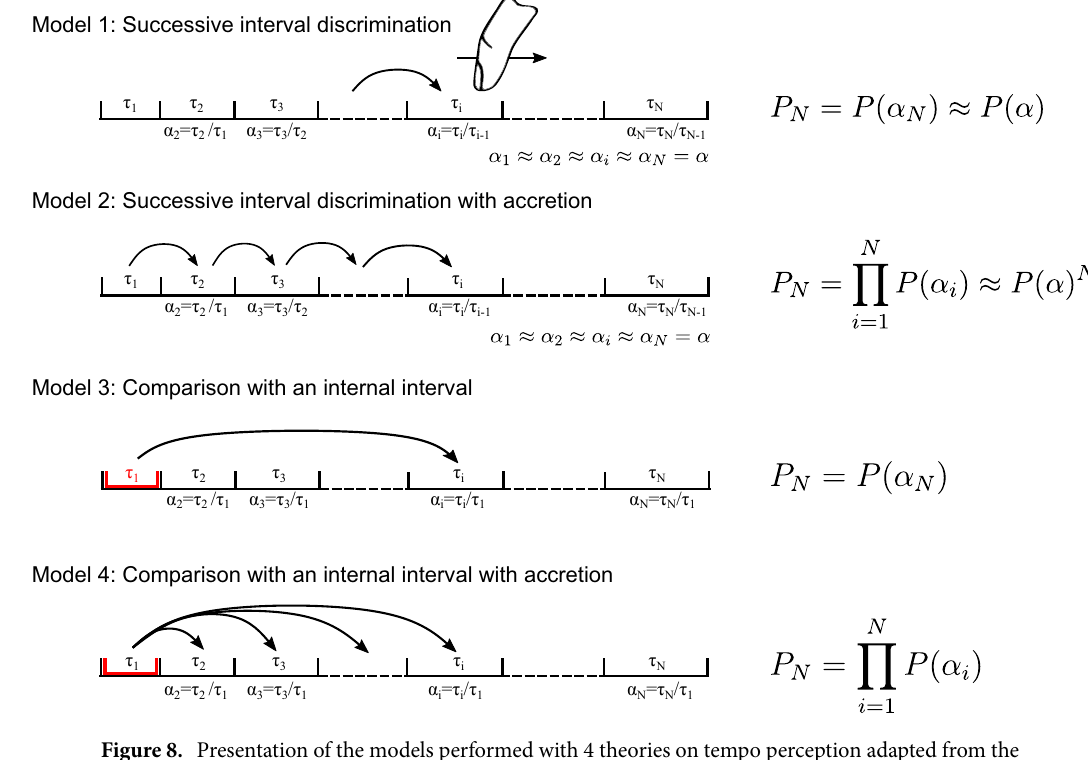
Figure 8. Presentation of the models performed with 4 theories on tempo perception adapted from the